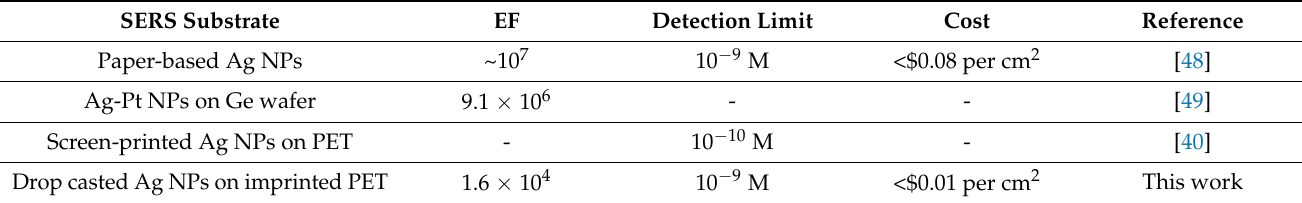
Table 2. Comparison of various low-cost substrates used to detect